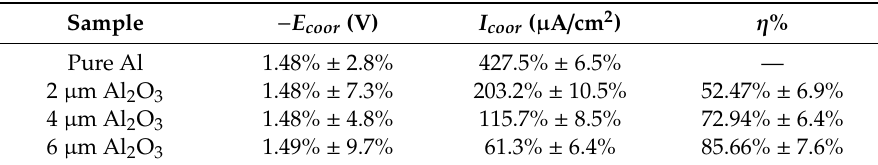
Figure 6. Potentiodynamic polarization curves of the Al anode modified by Al 2 O 3 interlayers of different thickness. Table 2. Corrosion parameters from polarization curves (the % errors are mentioned with the corrosion parameters).